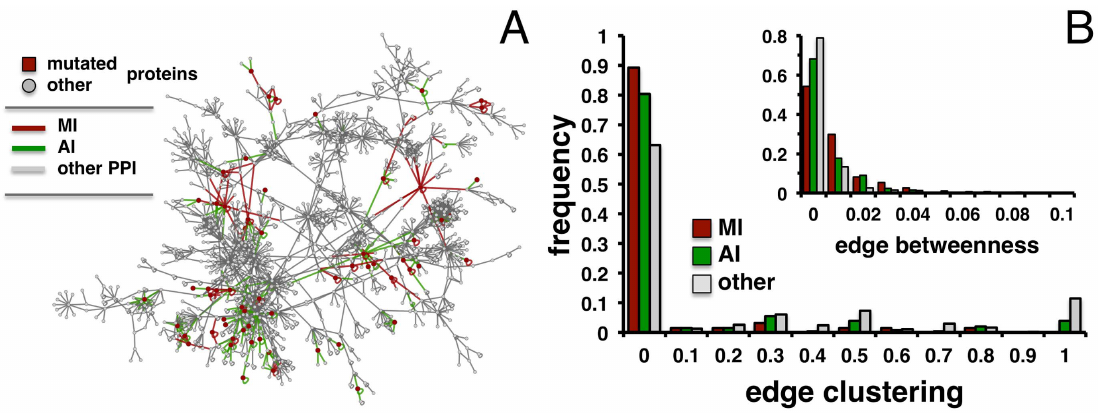
Figure 4. Network analysis of protein interactions that are affected by mutations. ( A ) By mapping all structurally inferred interactions that suffer from a mutation on their interfaces in a human interaction network (MI) we obtained a largest component capturing 1,960 interactions. Furthermore, we indicated all interactions that involved a mutated protein (AI). ( B ) Calculating edge clustering of MI and AI interactions in the largest component, we observed that interactions affected by a mutation generally tend to appear in less clustered areas. Compared to the remaining interactions, such differences were significant for both MI and AI interactions (p-value=5 6 10 2 8 , Wilcoxon test). Comparing MI and AI interactions, we observed a significant shift of MI interactions toward lower clustering (p-value=0.01). In the inset, we determined edge betweenness of MI and AI interactions as a measure of their centrality in the network. Compared to the remaining interactions, we found that differences between both sets of interactions affected by mutations were statistically significant (p-value=5 6 10 2 3 ). Furthermore, MI showed significantly lower betweenness than AI interactions (p-value=0.01).